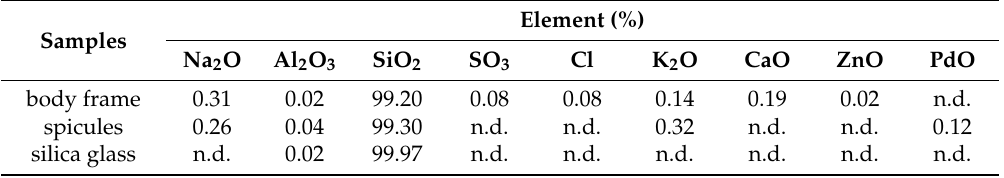
Table 1. Chemical composition of glass sponge body frame and spicules. The PdO content is explained in the text. The values of silica glass were reported by Fukushima